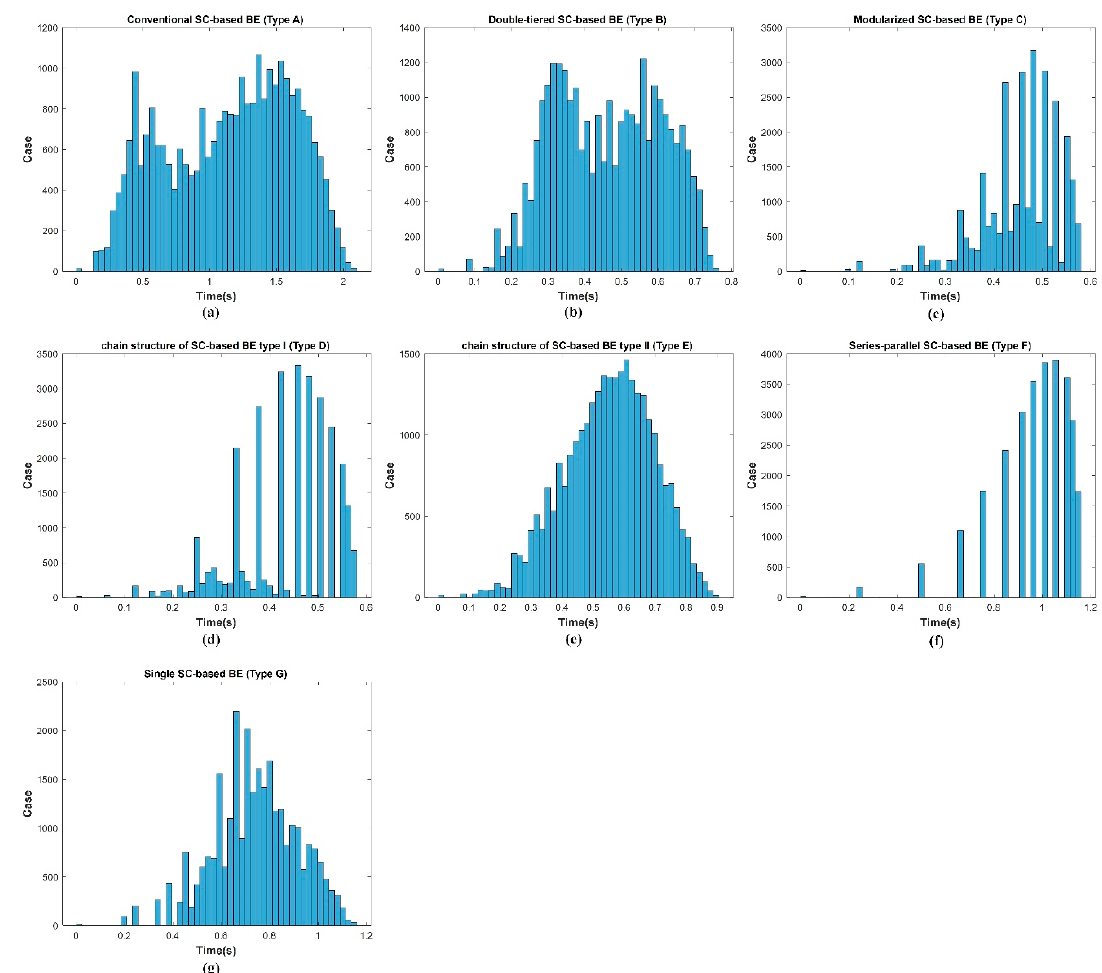
Figure 18. Histogram of the balancing times for all 28,561 cases for 4 battery cells: ( a ) type A; ( b ) type B; ( c ) type C; ( d ) type D; ( e ) type E; ( f ) type F; ( g ) type G. Table 5. Average balancing times of 8 battery cells using different SC-based